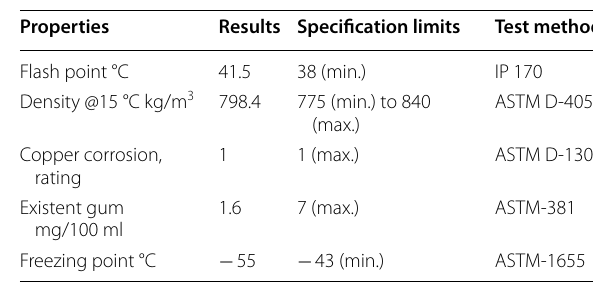
Table 5 Specifications of jetA1 blended with 5% of